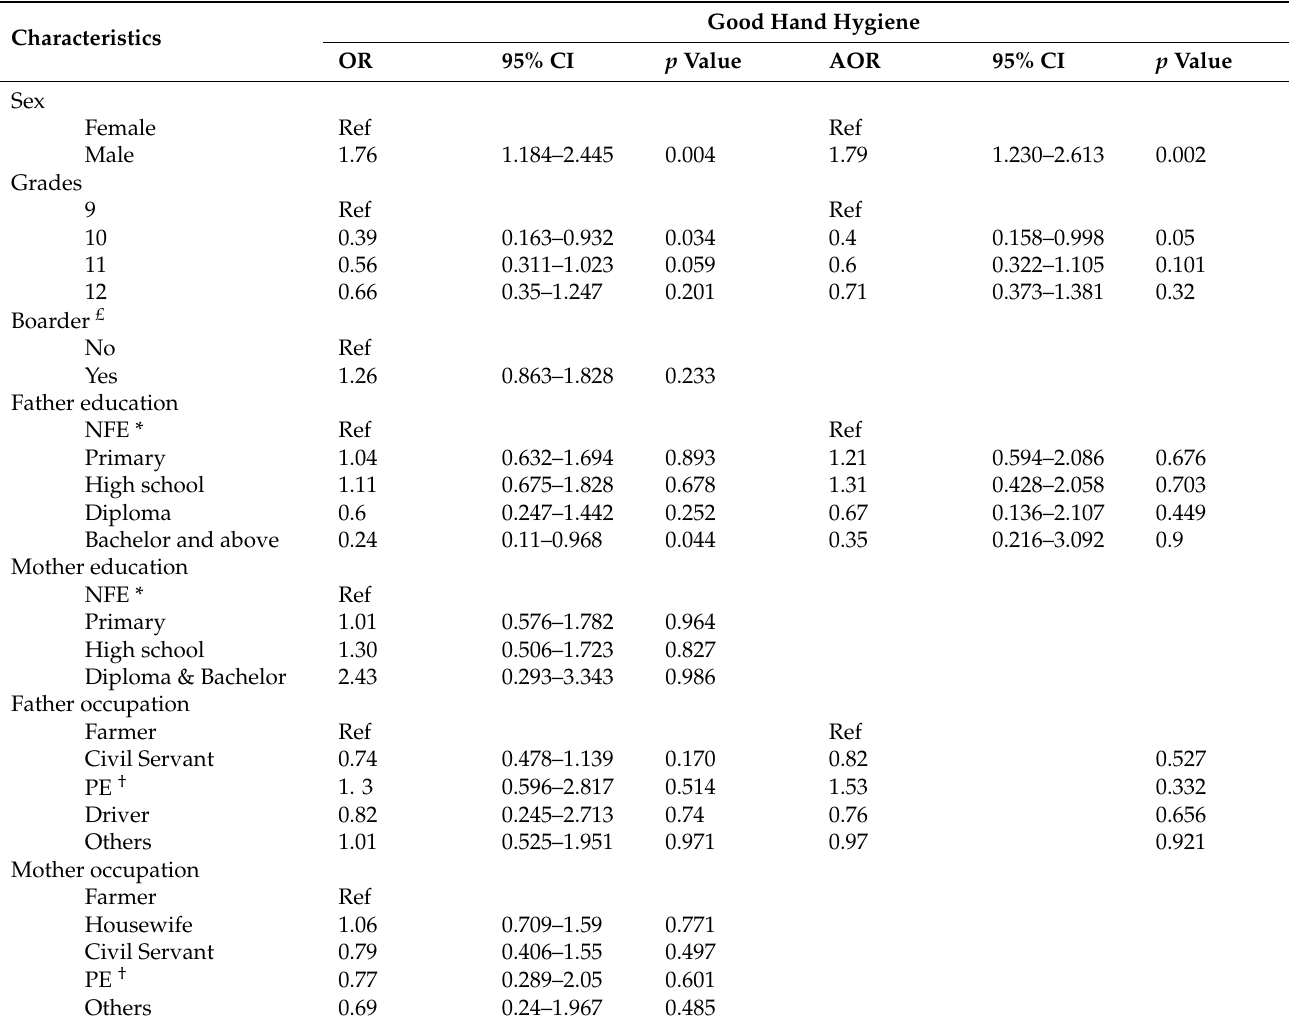
Table 2. Multivariable logistic regression of good hand hygiene among the students of Mongar Higher Secondary School, Bhutan.